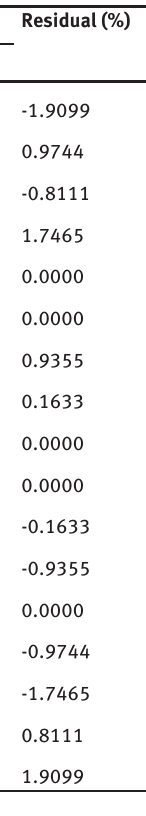
Table 2: Results of the experimental and predicted values for production of biodiesel using microwave with CaO catalyst from eggshells